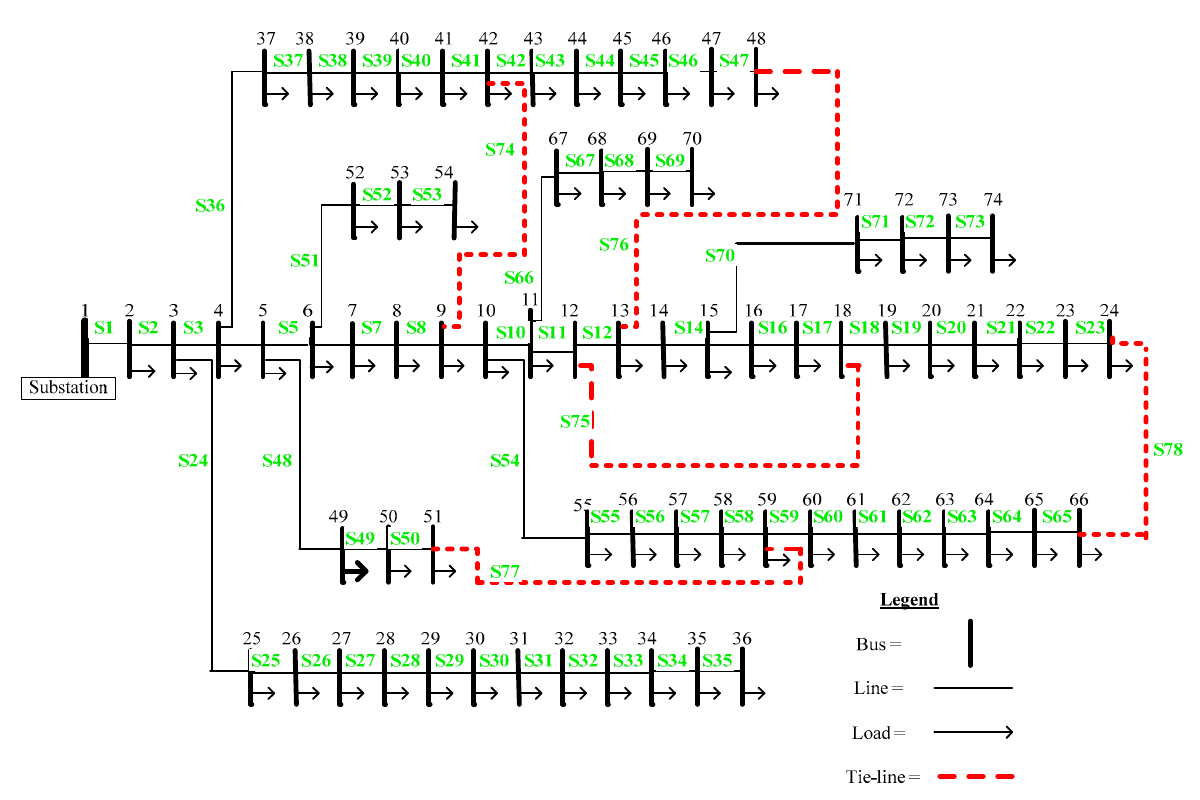
Figure 3. Single line diagram of Debre Markos Feeder-3. Table 1. SR simulation result for single fault case without considering protection constraints.